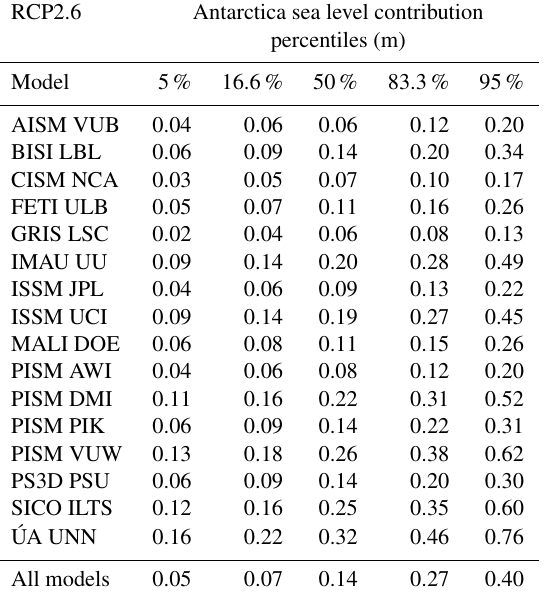
Table 7. Percentiles of the probability distribution of the sea level contribution of Antarctica for different ice sheet models under the RCP2.6 climate scenario. The 50th percentile corresponds to the median; 16.6%–83.3% is the so-called “likely range” as denoted in the IPCC reports. The “very likely range” is given by the 5th–95th